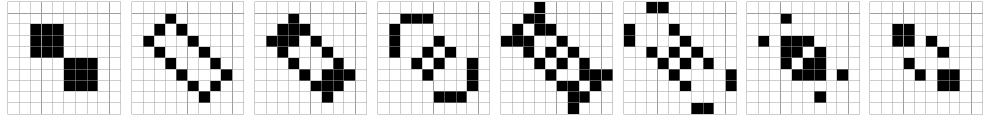
Figure 1. Recreation of “Big beacon,” a period-8 oscillator pattern in Life described in